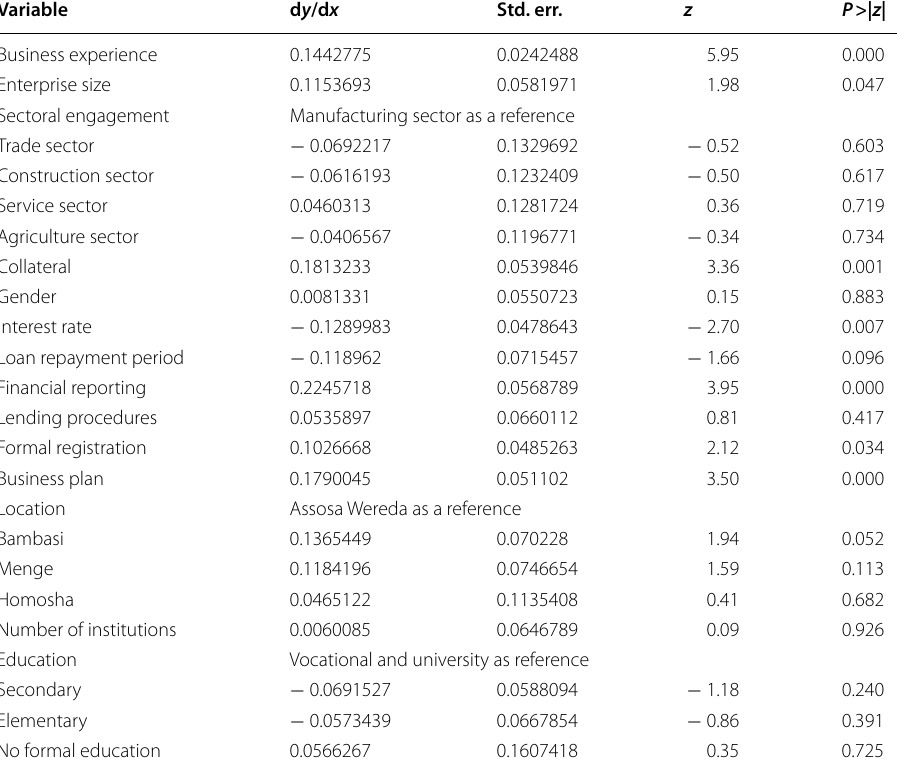
Table 6 Determinants of access to credit (marginal effects from probit estimation) Variable d y /d x Std. err.